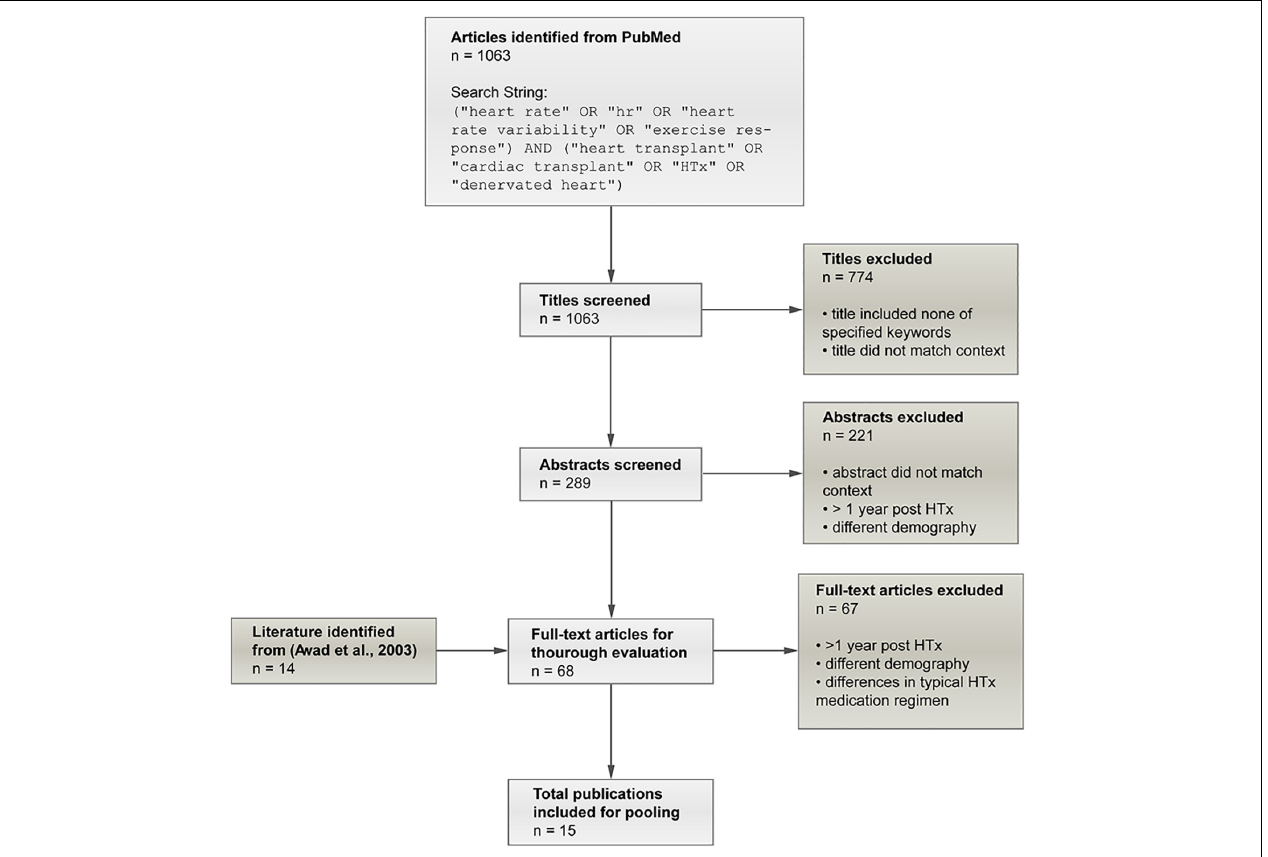
FIGURE 2 | Summary of the screening process applied to identify eligible publications for data pooling. In the initial screening phase, publications were excluded if the title did reveal that the study includes hemodynamic variables neither for rest nor exercise and thus did not match the expected context. Finally, 15 publications (McLaughlin et al., 1978; Crisafulli et al., 1985; Kavanagh et al., 1988; Labovitz et al., 1989; Wilson et al., 1991; Marzo et al., 1992; Rudas et al., 1993; Kao et al., 1994; Doering et al., 1996; Geny et al., 1996; Notarius et al., 1998; Hayman et al., 2010; Peled et al., 2017; Nygaard et al., 2019; Nytrøen et al., 2019) could be identified as eligible for data